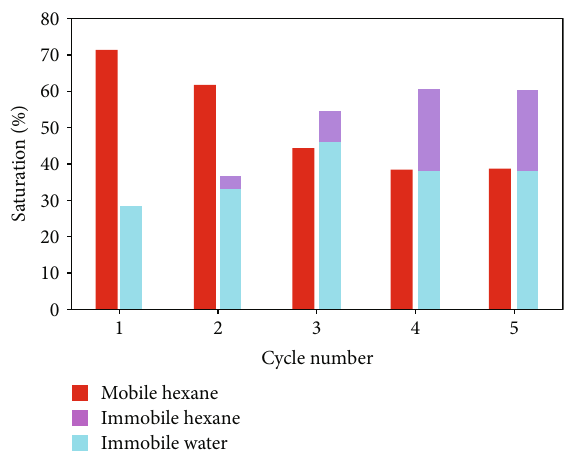
Figure 9: Steady-state saturations of fl uids in the selected segment at drainage cycles.